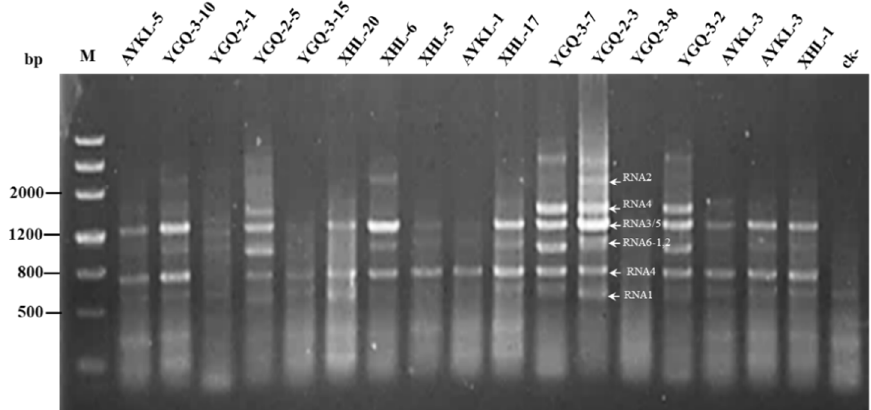
Figure 2. Electrophoresis of RT-PCR products obtained from 17 jujube samples positive to jujube yellow mottle-associated virus (JYMaV) by using the primer set 5H/3C. ck-, a leaf sample of a healthy jujube plant from Hubei Province. M, DNA marker Ⅲ . Bands of RT-PCR products from sample YGQ-2–3 were marked with the viral RNAs basing on their sequences.